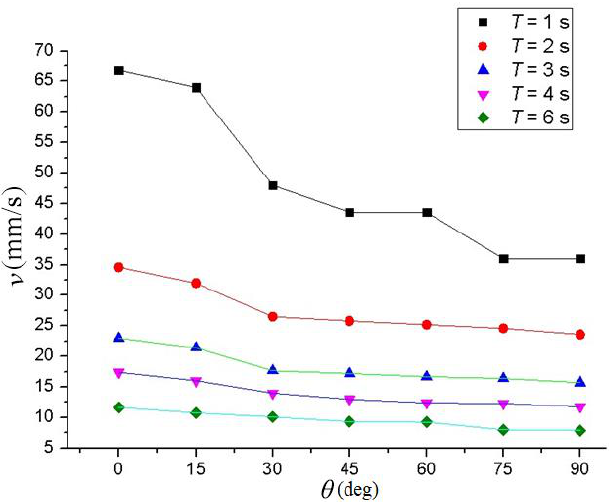
Figure 17. The influence of the oscillation period and slope gradient on the walking speed of the robot.